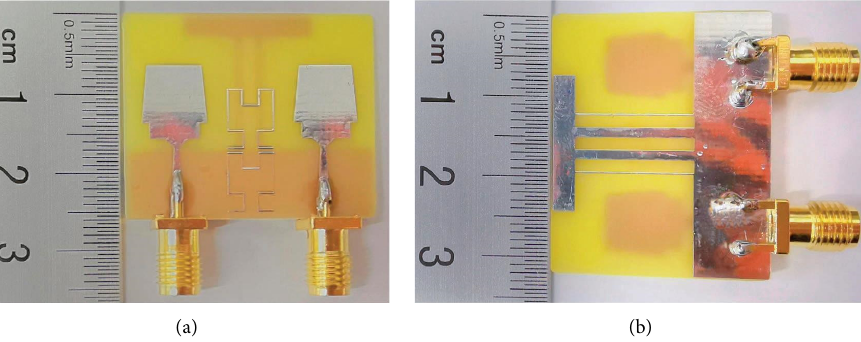
Figure 11: Physical view of the antenna. (a) Top. (b) Bottom.